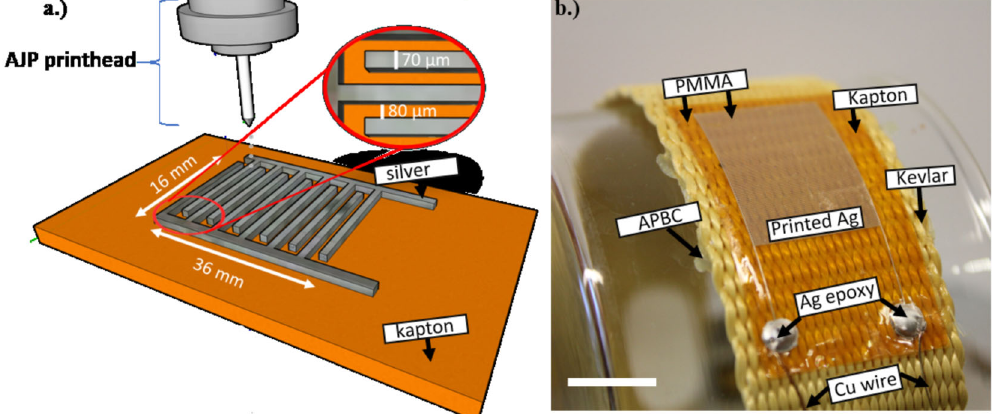
Fig. 1 Design of printed fl exible interdigitated electrode capacitive strain gauge. a Schematic of the sensor con fi guration having an interdigitated electrode structure containing 50 digit pairs, b Optical image of capacitive strain gauge on Kapton substrate attached to Kevlar strap (scale bar represents 1